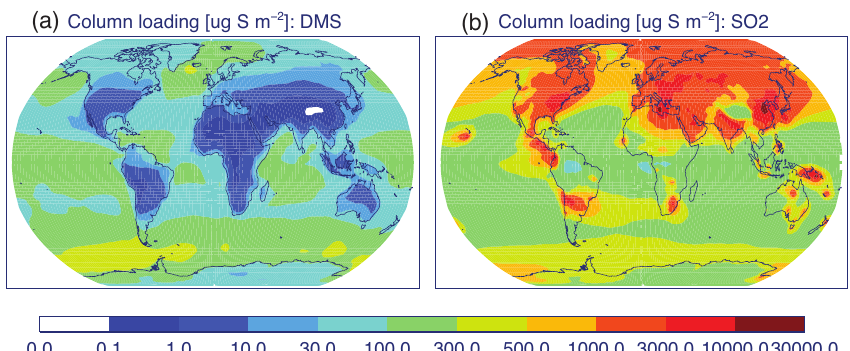
Figure 1. Annual-average column mass concentrations of (a) DMS and (b) SO 2 in the ModelE2-TOMAS BASE run. Units are µgSm − 2 .